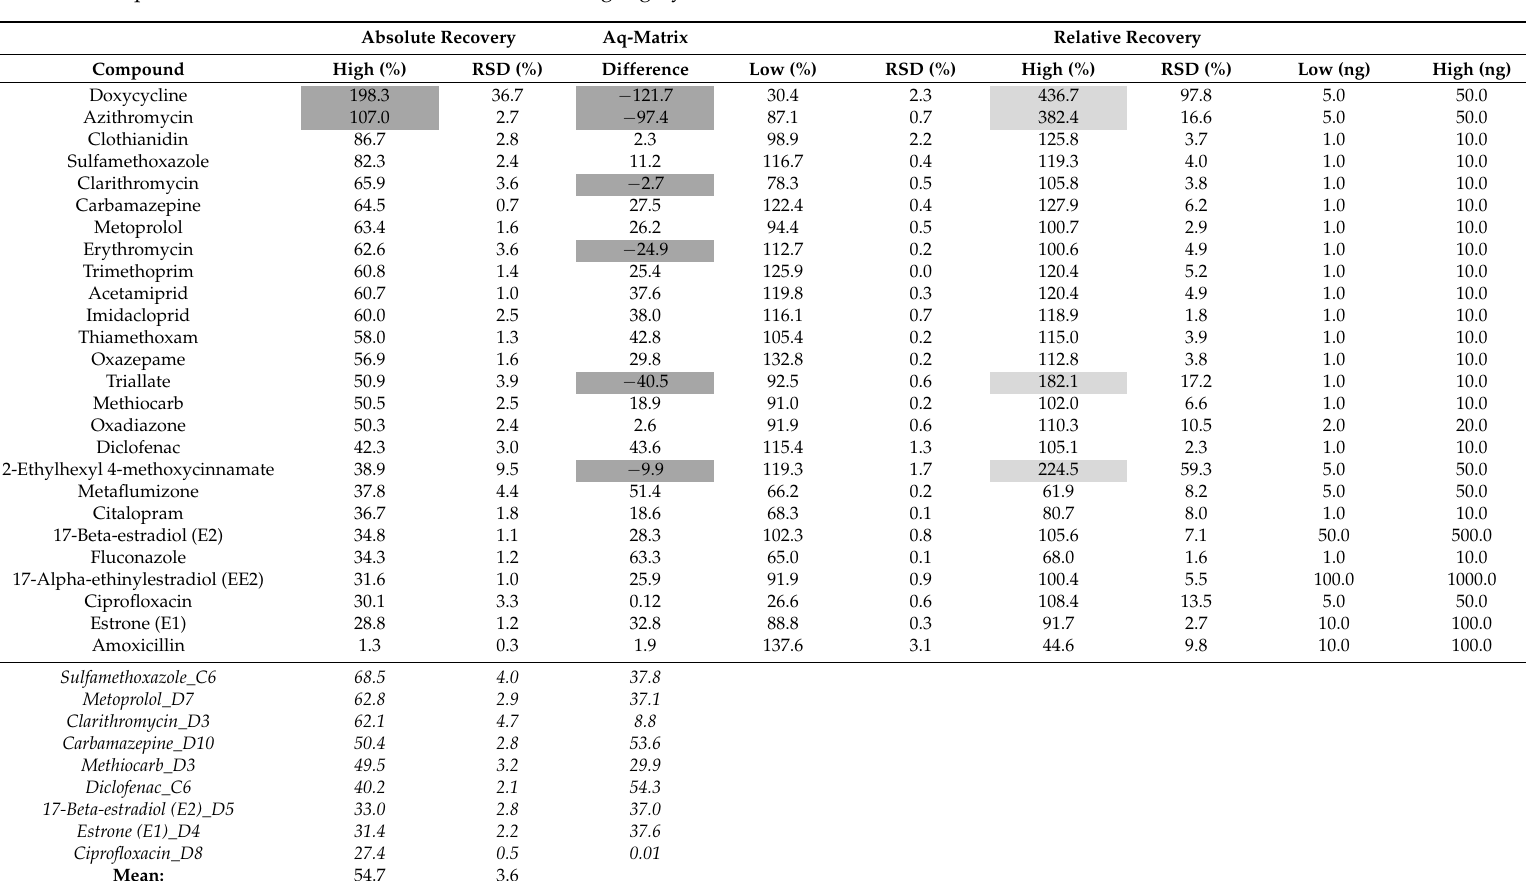
Table 2. Absolute and relative recoveries of 26 compounds spiked in 0.5 liter diluted matrix-rich pond water (1:5) at high and low concentration levels applying a flow rate of 40 mL/min. The experiment ran as a triplicate. The absolute amount (ng) of compounds spiked to the sample at low and high levels are shown in column 9 and 10. The absolute recovery is calculated for the high-level values as in the previous experiment (Table 1). Compounds are ranked based on absolute recovery, highest to lowest. The 9 IS are indicated in italic. Six compounds showed higher absolute recovery in the presence of matrix and two of them exceeded 100 %, grey marked. Four compounds showed excessive relative recoveries, light